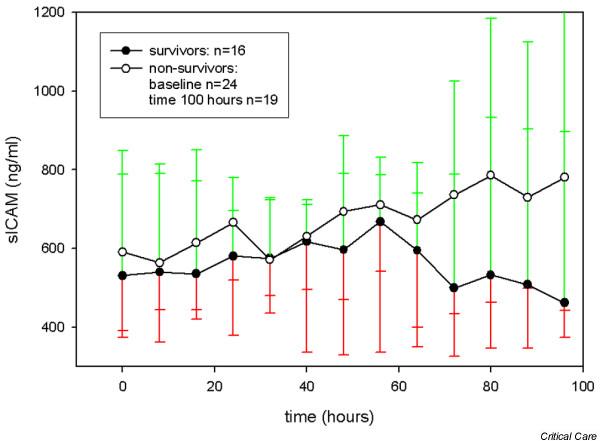
Soluble intercellular adhesion molecule 1 (sICAM-1) for survivors and non-survivors over time.